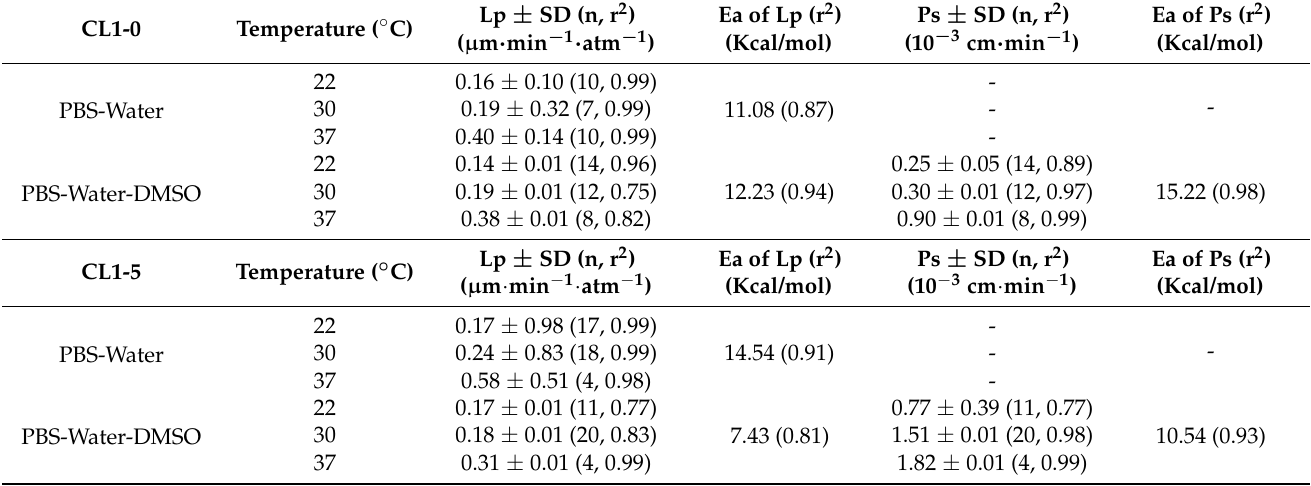
Table 1. Lp, Ps, and Ea of CL1-0 & CL1-5 cells at various temperatures (mean ± standard